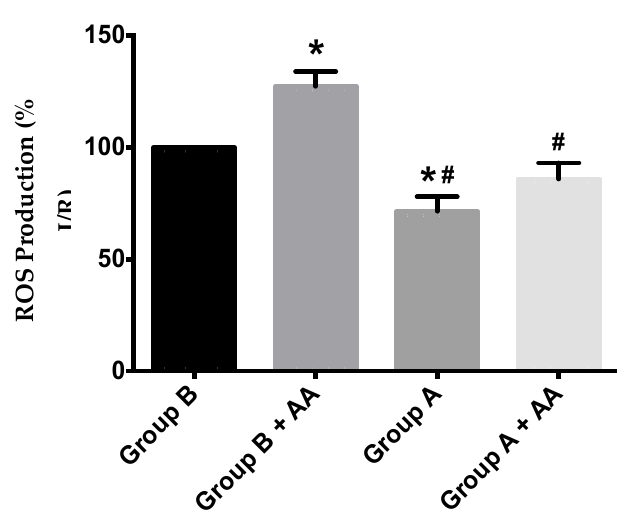
Figure 9. ROS production in hepatic mitochondria of rats subjected to liver ischemia/reperfusion (I/R, Group B), without or with pre-treatment with berberine (BBR, Group A), as evaluated by following 2 ′ ,7 ′ -dichlorodihydrofluorescein diacetate (H 2 DCFDA) fluorescence. Mitochondria were isolated from animals sacrificed after 12 h of hepatic exposure to preservation solution and 1 h of reperfusion, as described in the Materials and Methods Section. Control animals were sham operated. After basal H 2 O 2 production was recorded, antimycin A (AA) 1.25 nmol/mg protein was added to the same wells, and the elevation of the generation of H 2 O 2 due to the respiratory chain blockade was recorded. I/R (Group B) unexpectedly elevated basal ROS generation over Group A, an effect that was further exacerbated by AA blockade of the respiratory chain activity. BBR supplementation (Group A) reduced ROS generation in both situations back to control levels. Bars represent the means ± SEM of an n = 4 different experiments. * indicates a p < 0.05 difference vs. Group B; # indicates a p < 0.05 difference vs. Group B + AA.